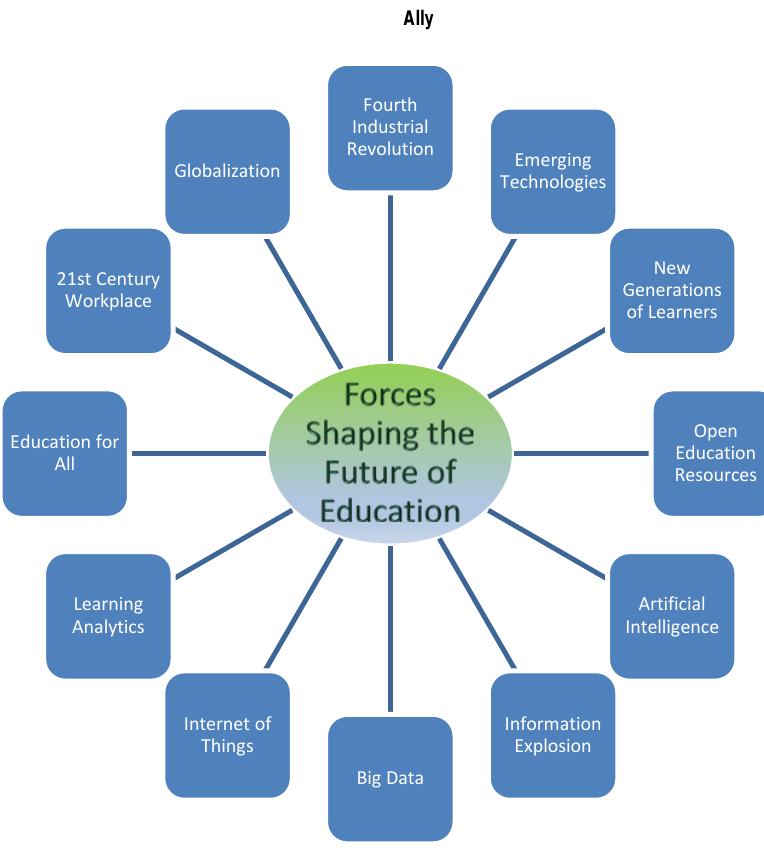
Figure 1. Forces shaping the future of education. The experts identified nine major themes that indicate the major areas of responsibilities for the digital teacher of the future (Figure 2) and 105 competencies that fall within the major themes. The following sections present the major areas of responsibilities followed by a list of competencies that fall within each major